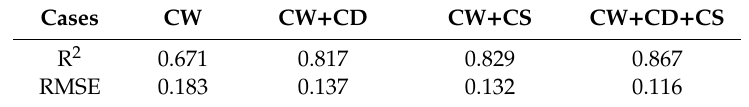
Table 2. Results of cases without stirrups and variables without including corrosion level ( n = 39).